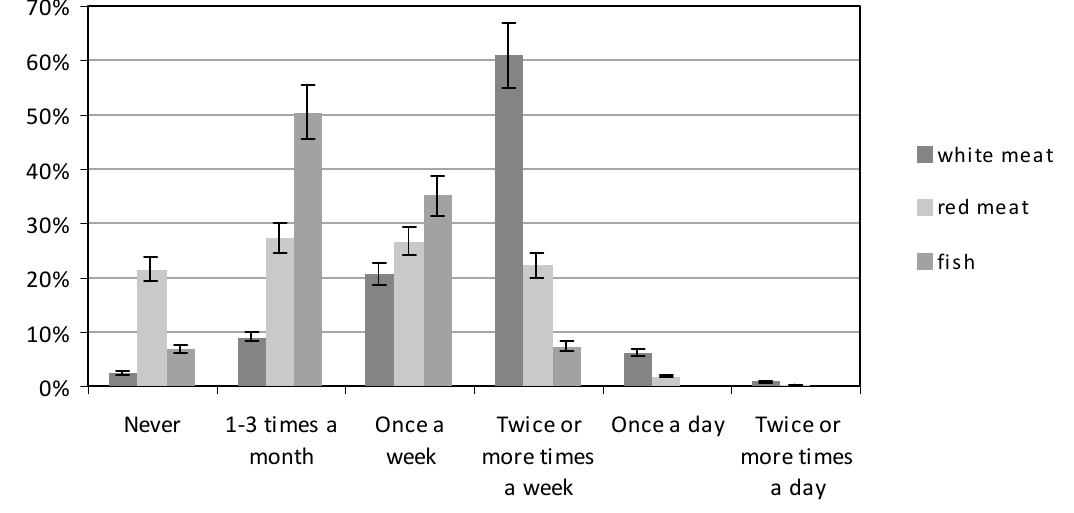
Figure 6. The consumption of meat and fish by participants.